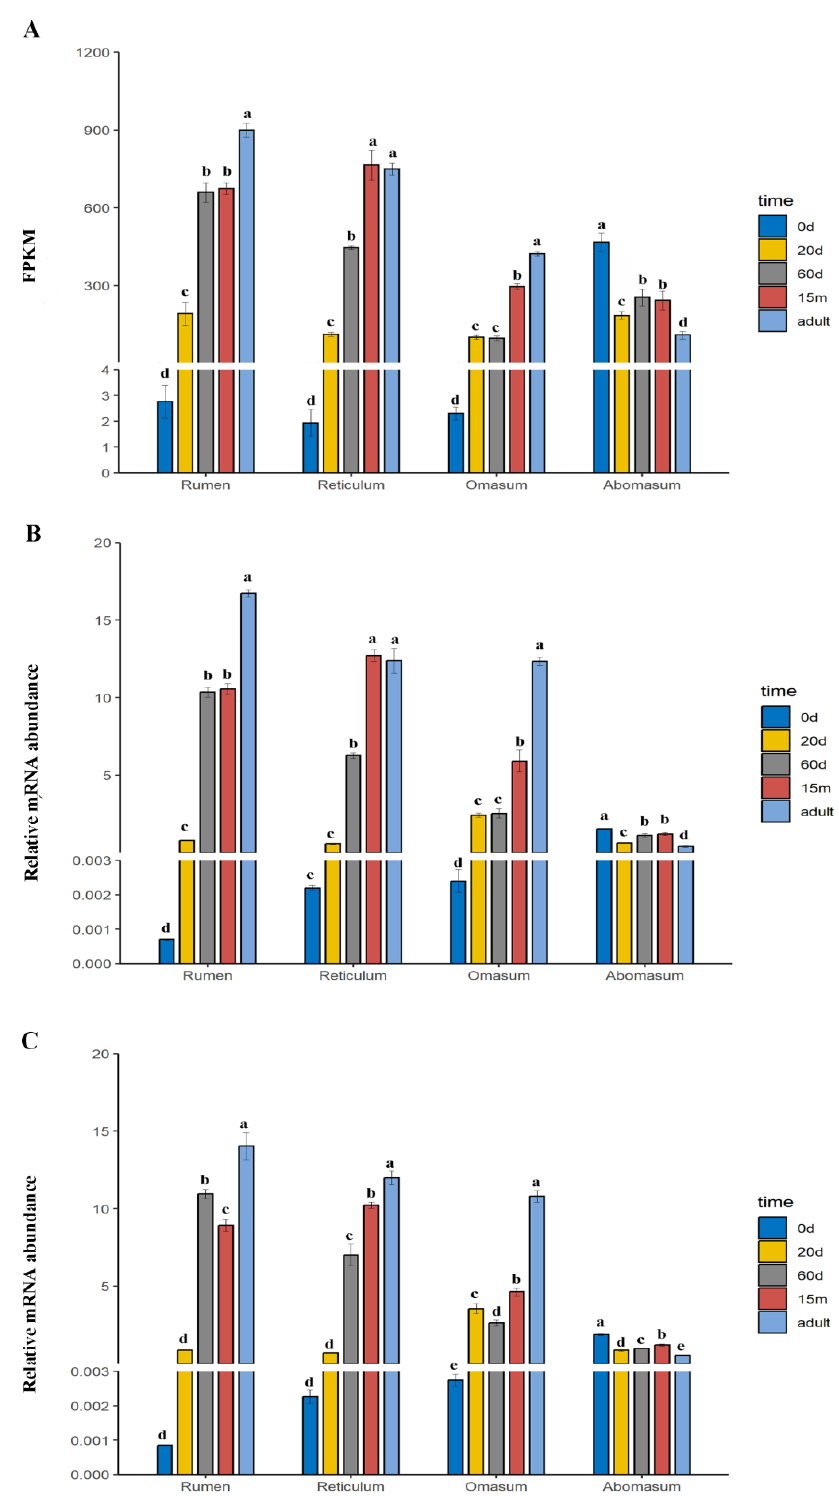
Figure 4. The expression levels of HMGCS2 ( A ) based on FPKM, ( B ) normalized using the 3 most stable CRGs ( RPS15 , MRPL39 and RPS23 ), and ( C ) normalized using the 3 least stable CRGs ( RPS9 , UXT and YWHAZ ). The values are means ± SE. Each histogram is divided into four groups (rumen, reticulum, omasum and abomasum). Within each group, the developmental stages with different superscripts indicate significant differences ( p < 0.05) in HMGCS2 expression between them. (For example, d is significantly lower than a, b and c.)